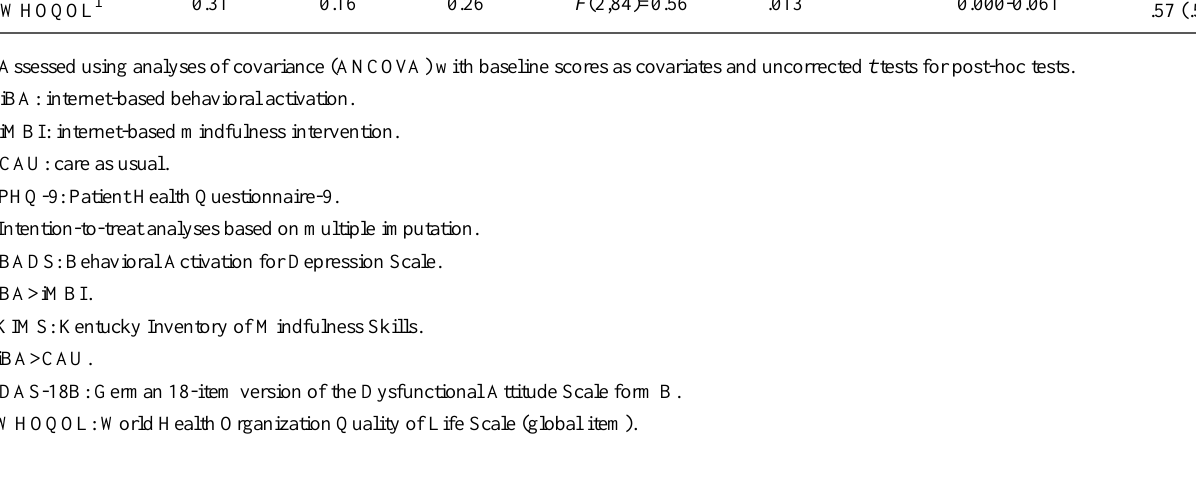
Table 4. Outcome analyses, including the effect sizes for and between-group differences in the outcome measures between the baseline (t 0 ) and 4-week follow-up (t 2 ) assessments in the complete-cases